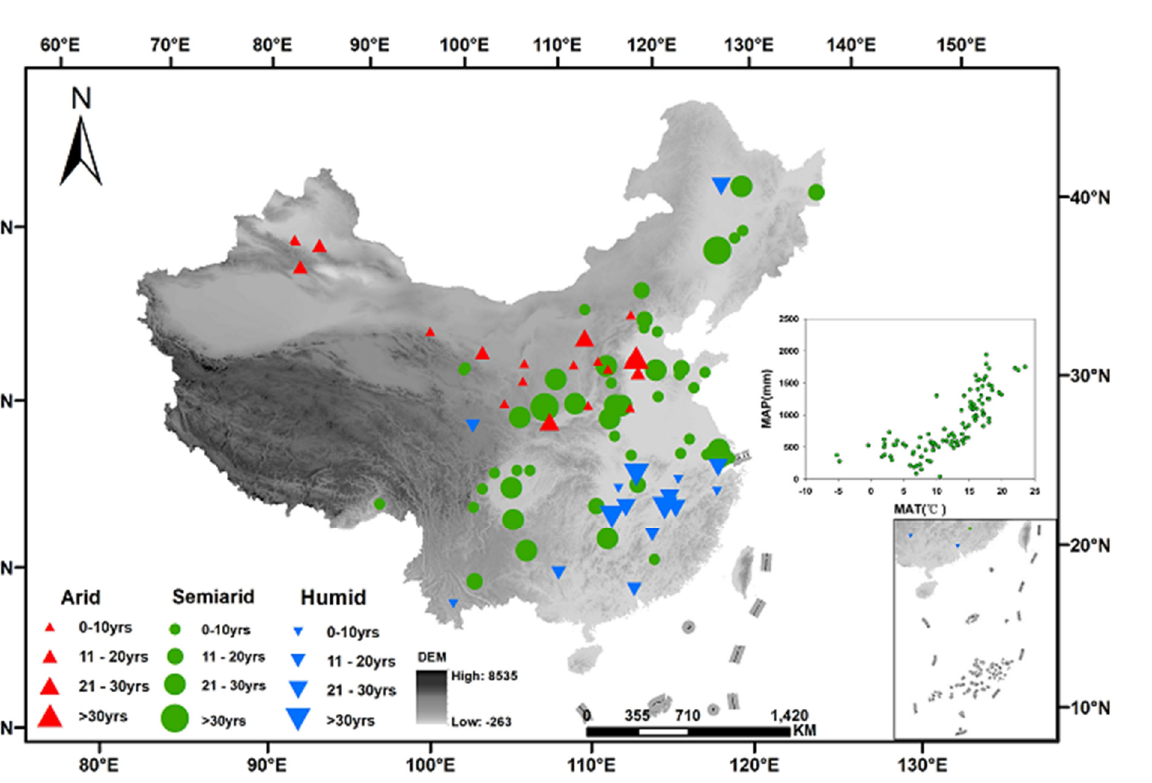
Figure 1. One hundred and nine long − term fertilization experimental stations in China, presented according to humidity index (HI = MAP/MAT + 10) and cultivation duration. triangles: arid (HI ≤ 25), circles: semi − arid (25 <HI < 50), inverted triangles: humid (HI ≥ 50). The size of symbols represents cultivation duration. The digital elevation model (DEM) is a digital simulation of the terrain using limited terrain elevation data. The map is based on the standard map released by the Ministry of Natural Resources of the People’s Republic of China (No. GS (2019)1822).